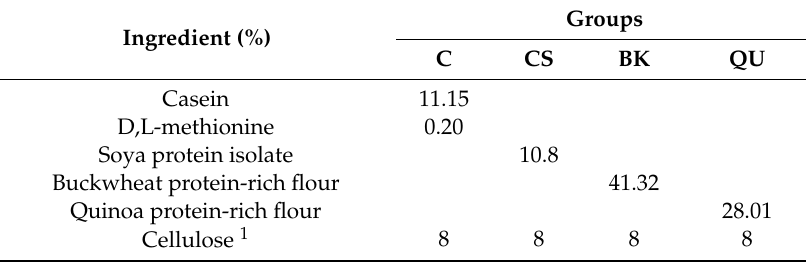
Table 1. Composition of the group-specific